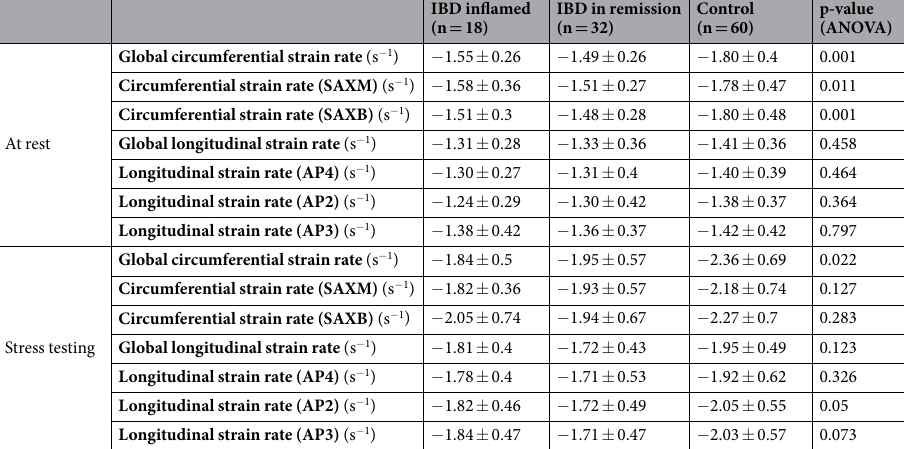
Table 3. Speckle tracking derived peak systolic LV strain rate at rest and during stress testing.